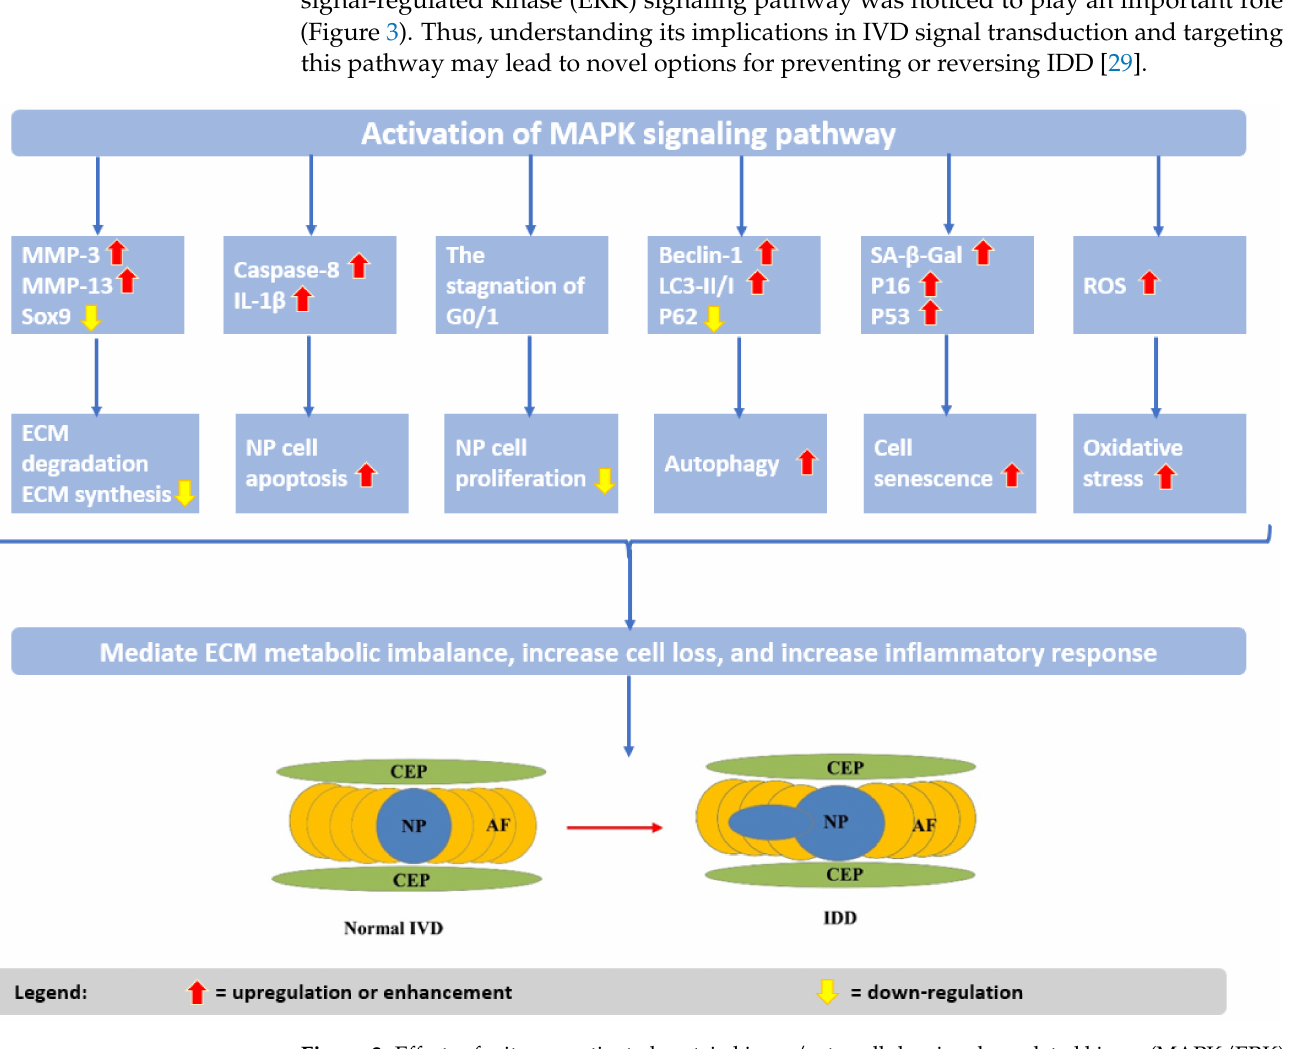
Figure 3. Effects of mitogen-activated protein kinase/extracellular signal-regulated kinase (MAPK/ERK) signal transduction on IDD. Adapted from an open access source